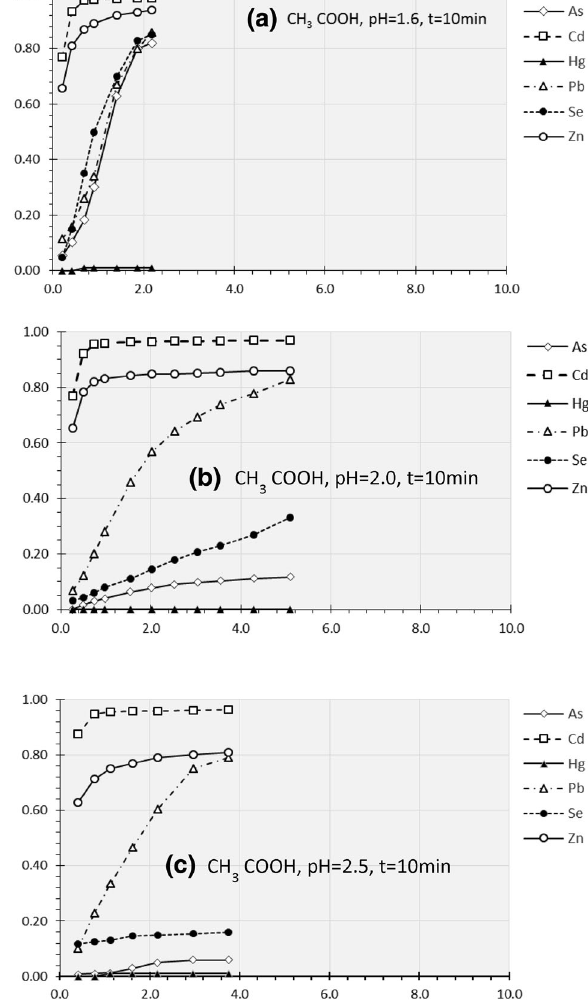
Fig. 8 Extraction yield versus volume (liters) for t = 10 min and pH = 1.6 ( a ); 2.0 ( b ) and 2.5 ( c